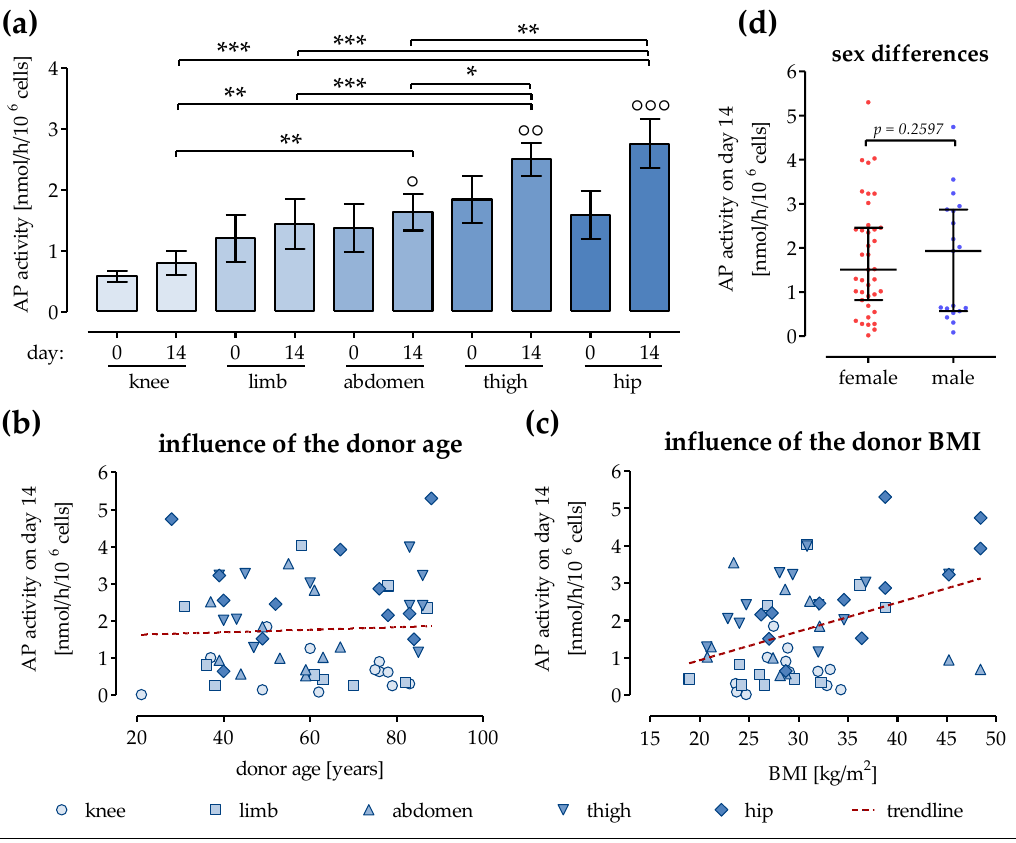
Figure 2. The alkaline phosphatase (AP) activity of Ad-MSCs varies depending on the donor site. Ad-MSCs derived from adipose tissue of the knee ( N = 12), limb ( N = 11), abdomen ( N = 11), thigh ( N = 12), and hip ( N = 12) were osteogenically differentiated for 14 days. ( a ) AP activity was determined on days 0 and 14 of differentiation; ( b ) AP activity on day 14 of differentiation as a function of the donor age; ( c ) AP activity on day 14 of differentiation as a function of the donor BMI; ( d ) Comparison of the AP activity of differentiated (day 14) Ad-MSCs from male and female donors; ° p < 0.05, °° p < 0.01, and °°° p < 0.001 when comparing day 0 with day 14 within each group; * p < 0.05, ** p < 0.01, and *** p < 0.001 as indicated.